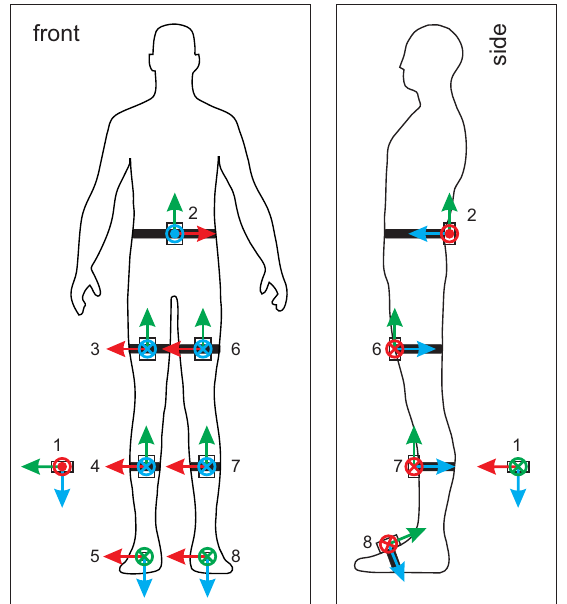
Figure 2. Attachment of wearable IMU sensors. Red axis arrows represent x axis, green axis arrow represent y axis and blue axis arrow represent z axis. All coordinate systems are right